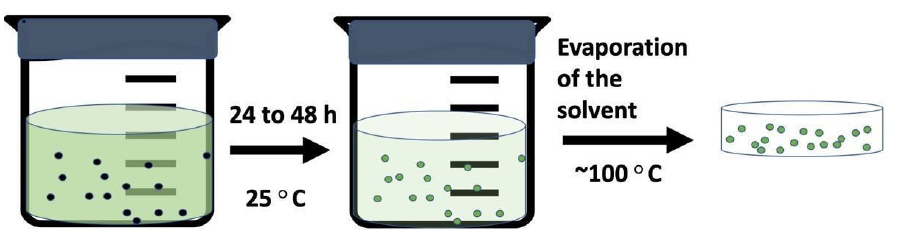
Figure 11. Liquid impregnation